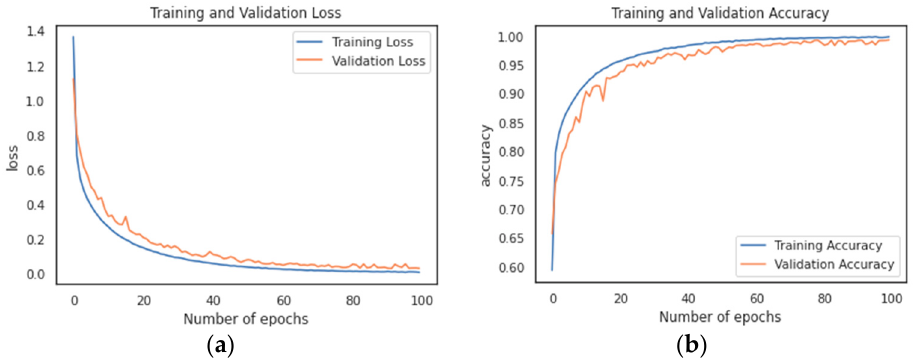
Figure 7. Line graph showing ( a ) accuracy plot and ( b ) loss plot as a function of number of epochs for the noncontextual model.